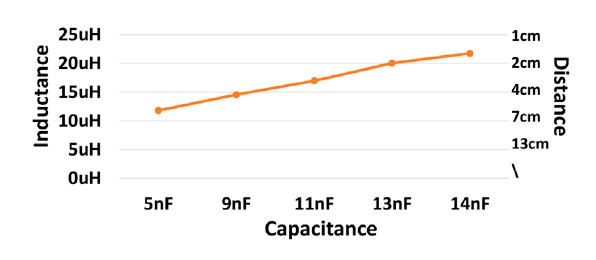
FIGURE 19 The curve of the distance of the coupled coil, after fi ve groups of auxiliary capacitors are connected in